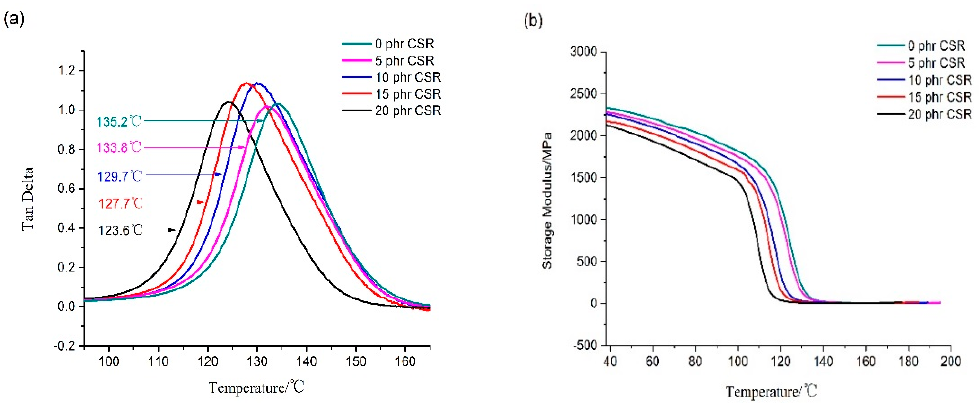
Figure 3. Dynamic mechanical analysis (DMA) test results of CSR nanoparticles modified epoxy resin: ( a ) Tan Delta curves of DMA test; ( b ) Storage modulus curves of DMA test.